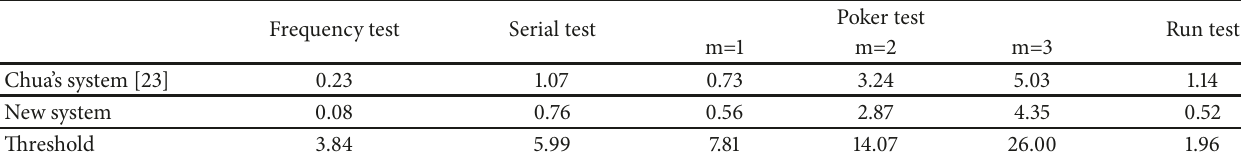
Table 2: Statistic test on sequences based on Beker and Piper